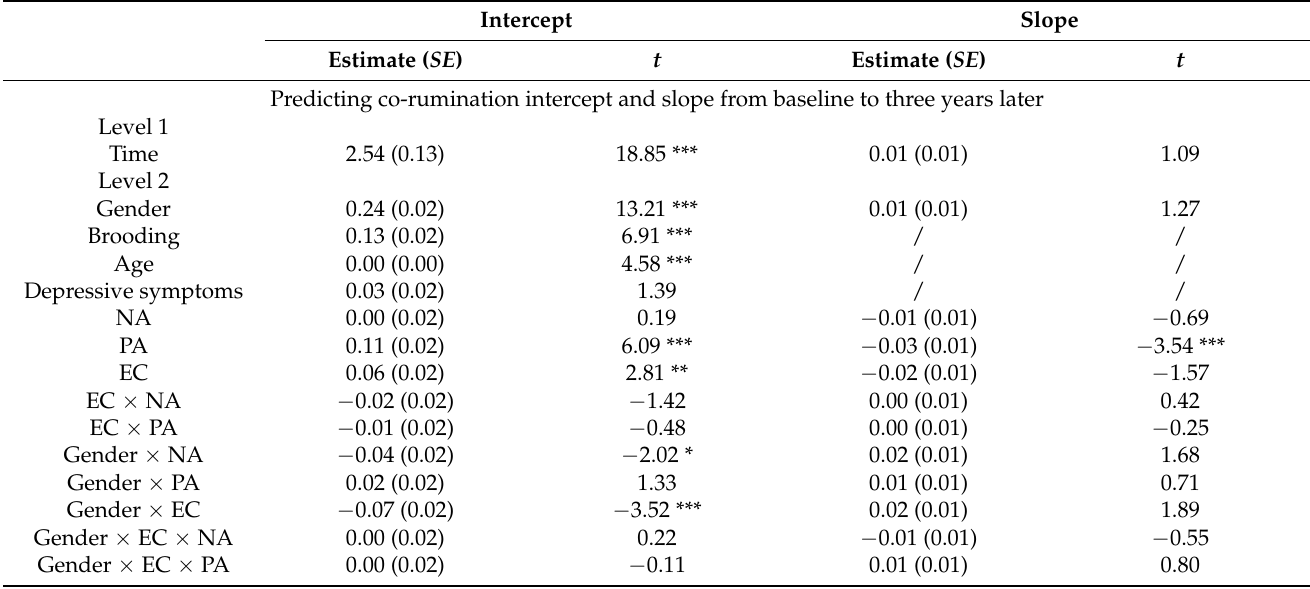
Table 4. Multi-level analyses predicting co-rumination trajectories as a function of the covariates, gender, and temperament. Intercept